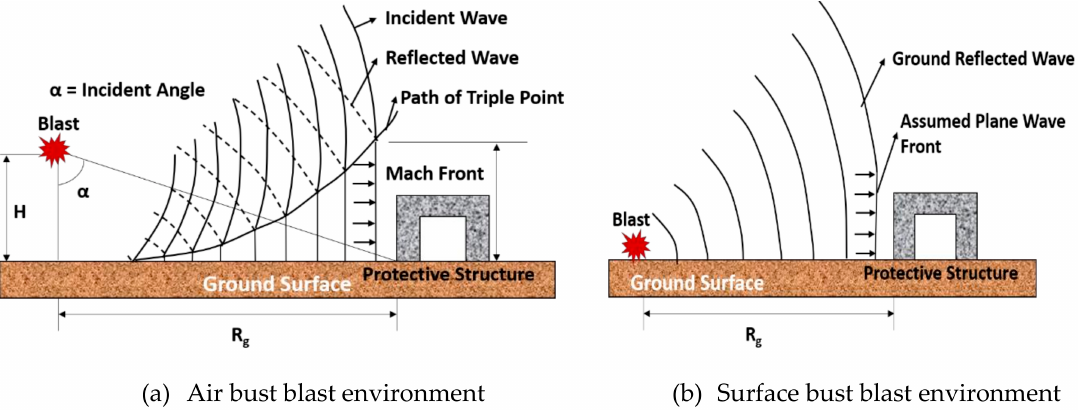
Figure 2. Propagation of blast